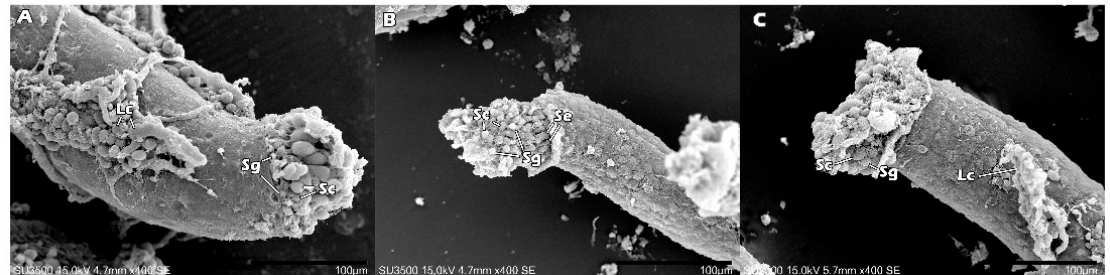
Figure 4. The mild crease shrinkage was noted on the outer surface of seminiferous tubules in the vitrified ITT with CPA ( C ), which was about two-thirds the size of seminiferous tubules of the fresh Abbreviations: Lc, Leydig cell; Se, Sertoli cell; Sg, spermatogonia; and, Sc, spermatocyte.